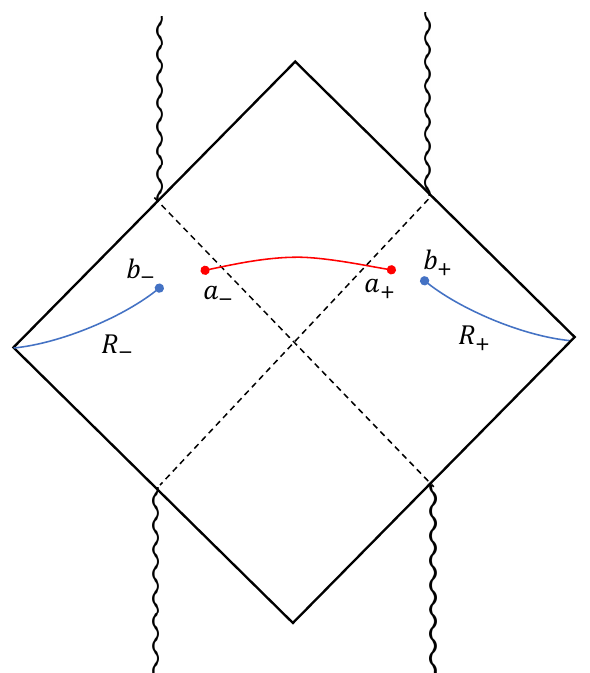
Figure 2 . Penrose diagram for the eternal Reissner-Nordström black hole with the assumption of island. The islands extend to the outside of the horizons of the black holes. The boundaries of islands are located at a + and a − . The points b ± are the boundaries of the left and right radiation regions R − and R +